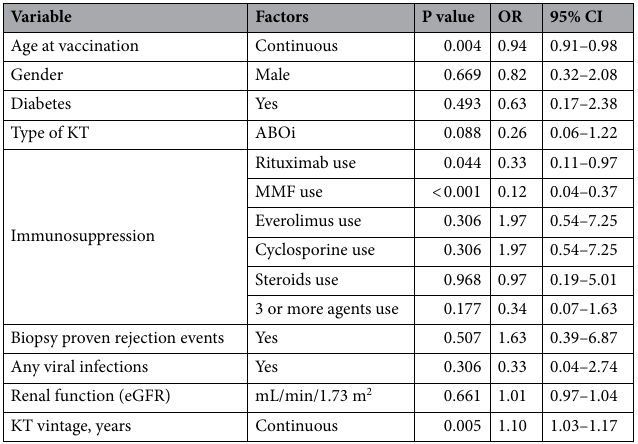
Table 2. Univariable logistic regression analysis. OR odds ratio, CI confidence interval.